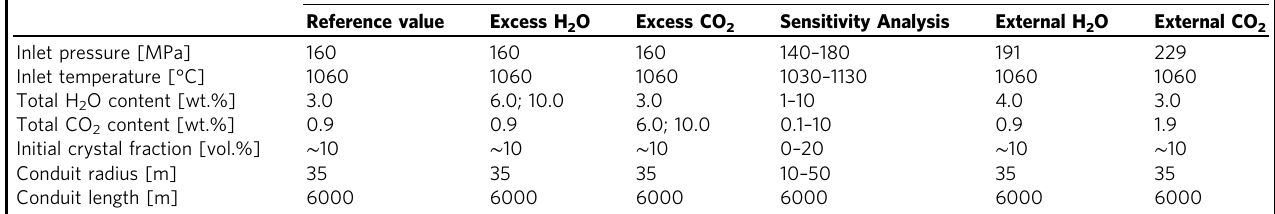
Table 1 Initial conditions for the reference numerical simulation of the Etna 122 BC Plinian eruption, for the excess H 2 O and CO 2 runs, for the sensitivity analysis, and for external increase in H 2 O and CO 2 (due to interaction with an external volatile source).